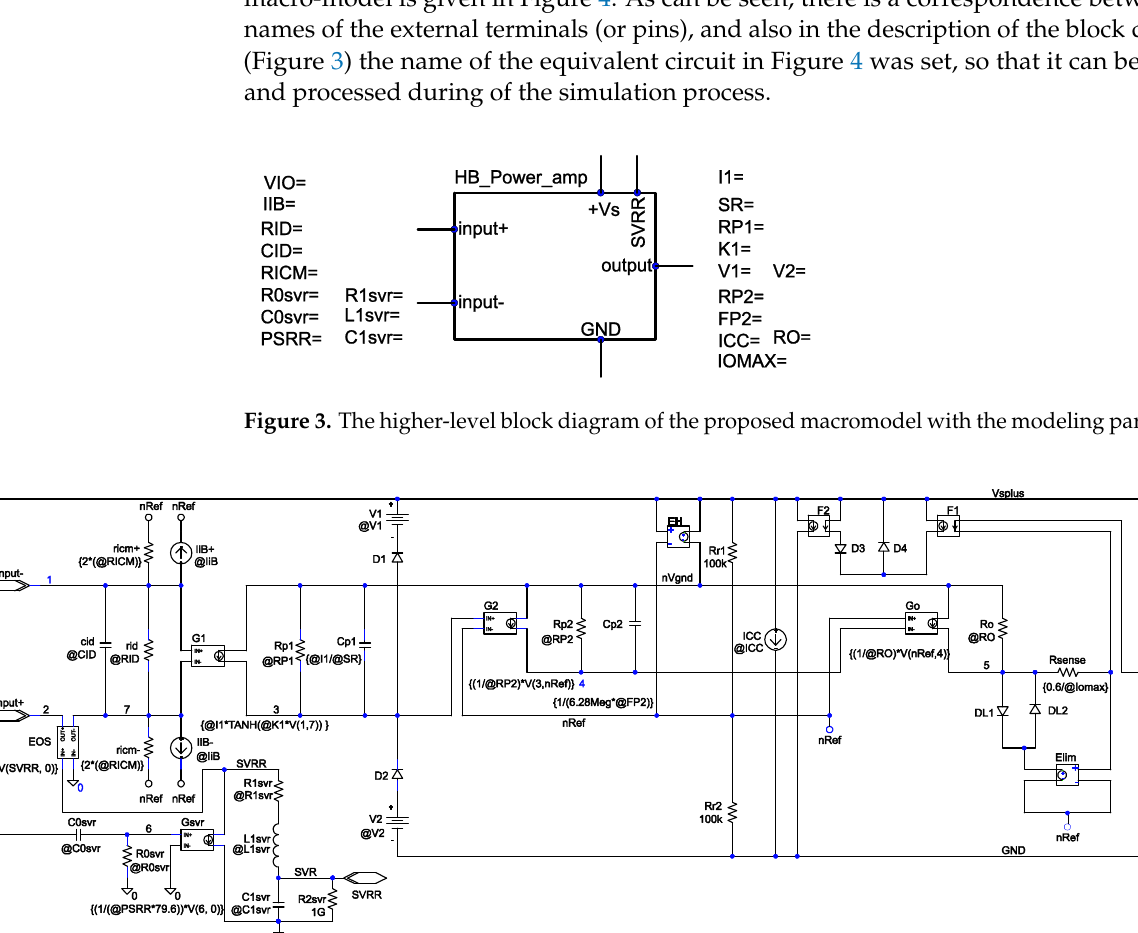
Figure 4. The equivalent electrical circuit of the proposed macro-model for power amplifiers.